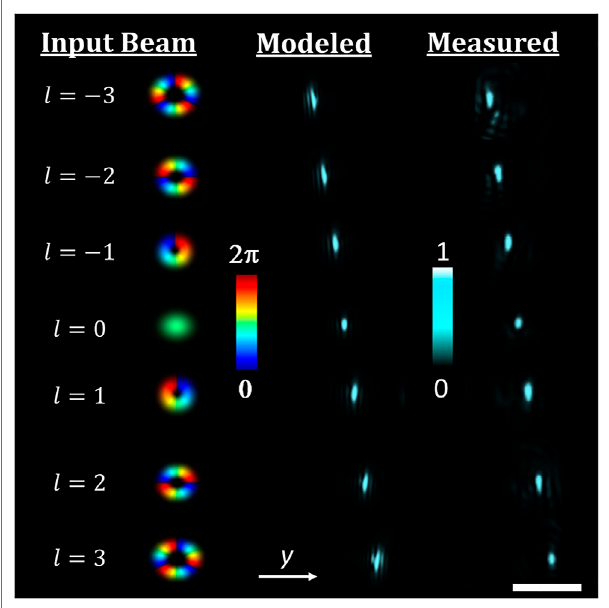
FIGURE 4 | Simulation results of a free-space OAM mode-sorter followed by experimental results. Each OAM state propagates onto a different location on the detector, with correlation to the state ’ s topological charge. Scale bar, 100 μ